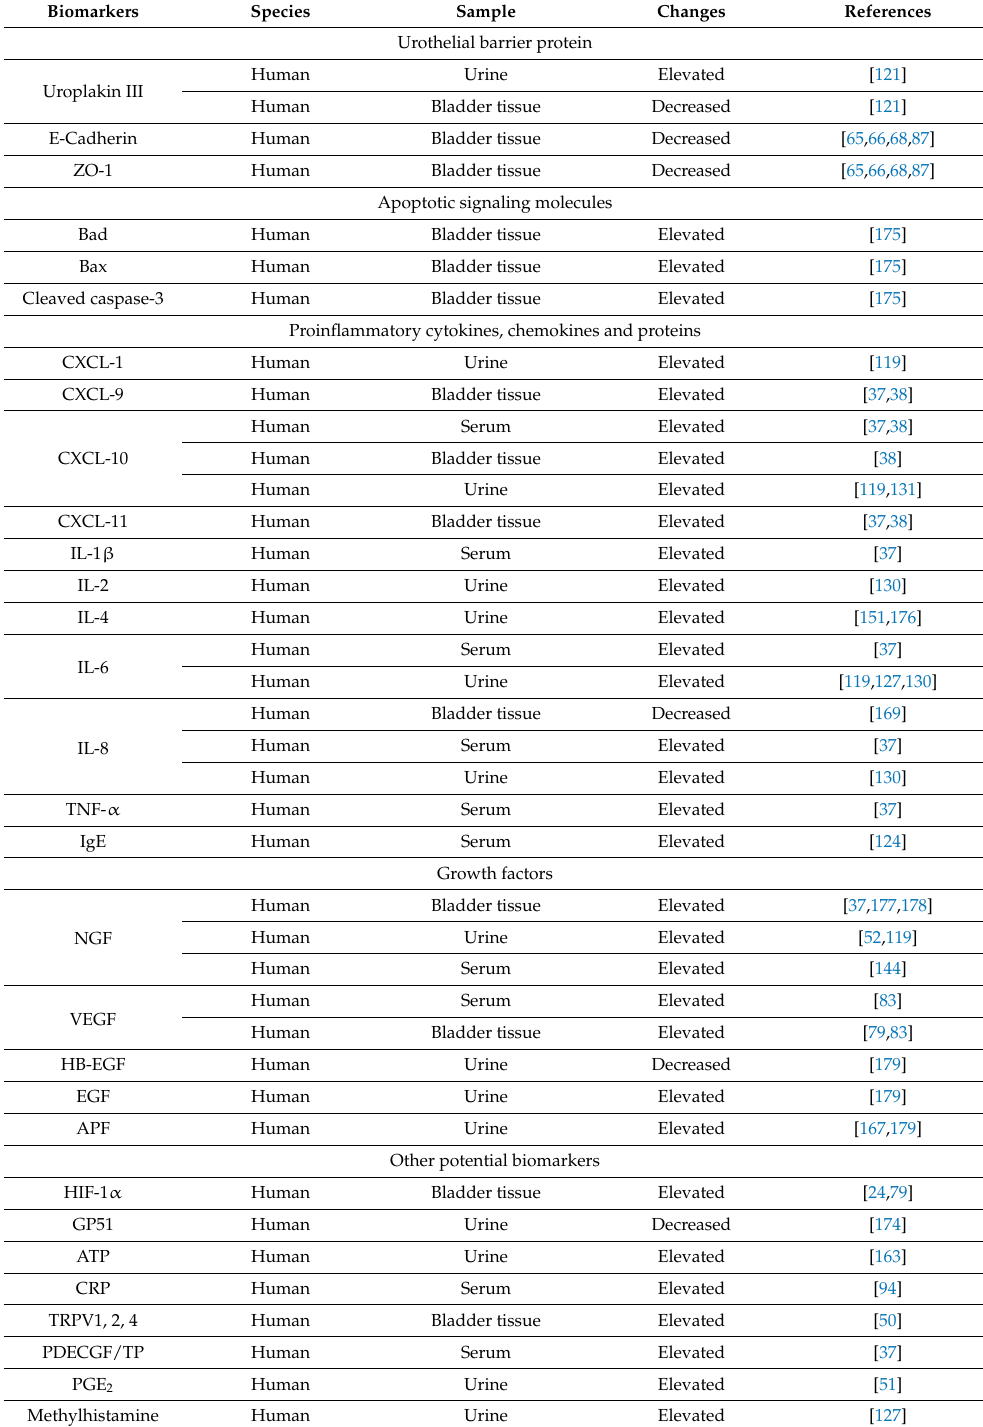
Table 3. Potential biomarkers of bladder tissue, urine, and serum for the diagnosis of